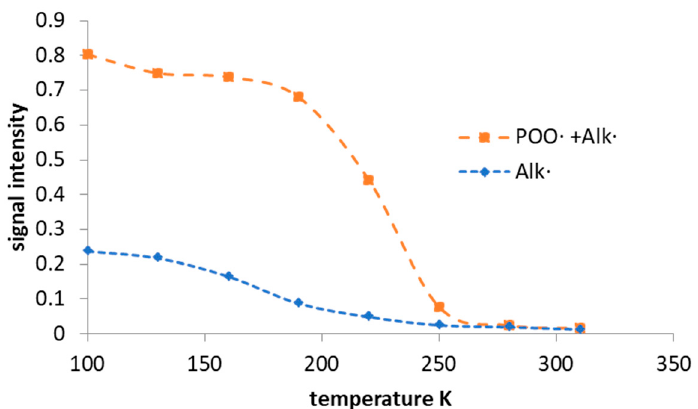
Figure 5. Intensities of the (POO • + Alk • ) and Alk • signal components in AO-unprotected, aged XLPE (52 kGy, low-rate) probe-irradiated in air at different temperatures at measurement. Dashed lines are guides for the eye.